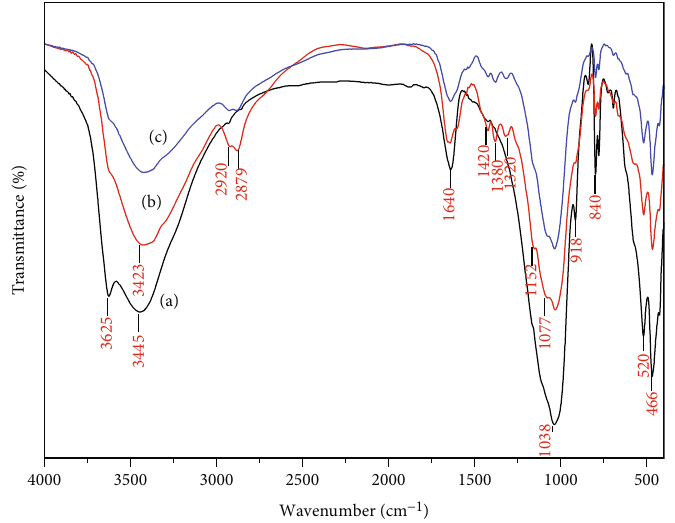
Figure 1: FTIR spectra of AlBT (a), CSBT (b), and CSBT after Cr (VI) removal (c).